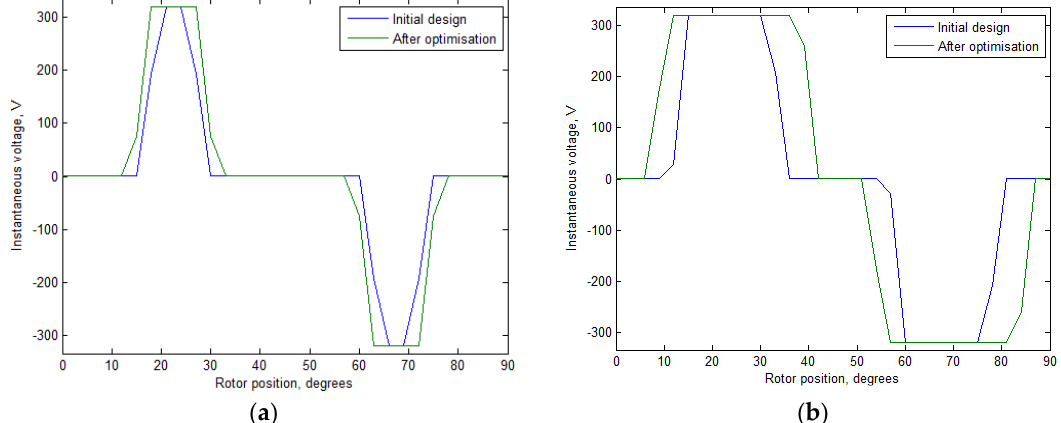
Mathematics 2021 , 9 , x FOR PEER REVIEW Figure 5. Voltage waveforms versus the rotor angular position before and after optimization: ( a ) mode 1; ( b ) mode 2.